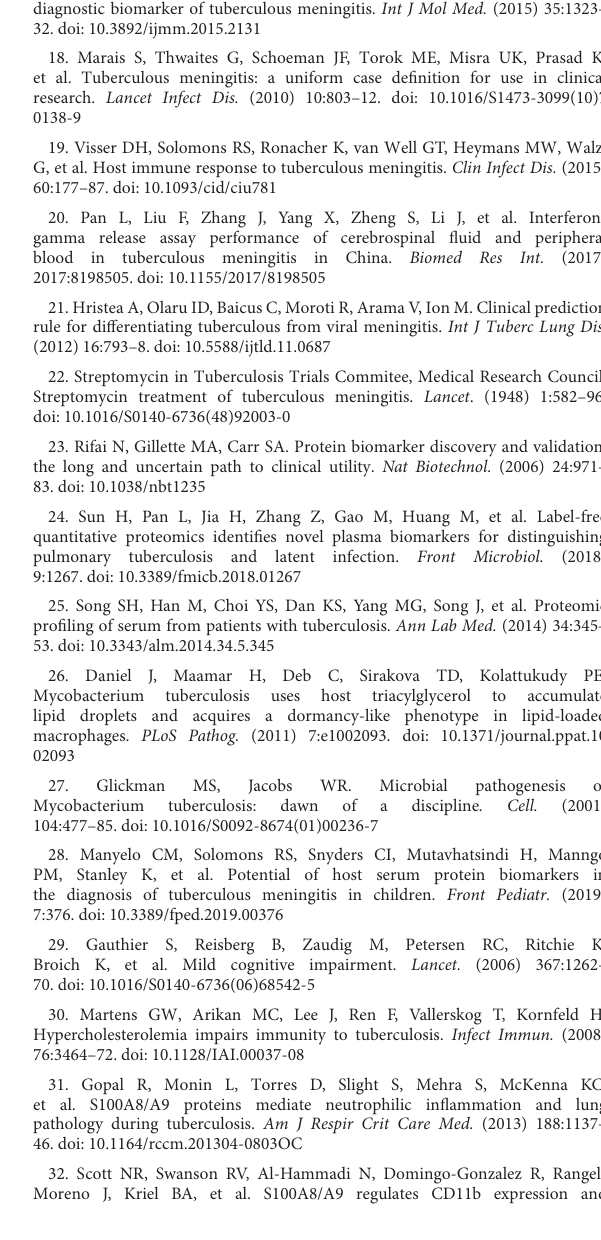
SUPPLEMENTARYFIGURE3 The expression of 8 proteins in patients with TBM with different disease stages. SUPPLEMENTARYFIGURE4 KEGG analysis of 7 differentially expressed